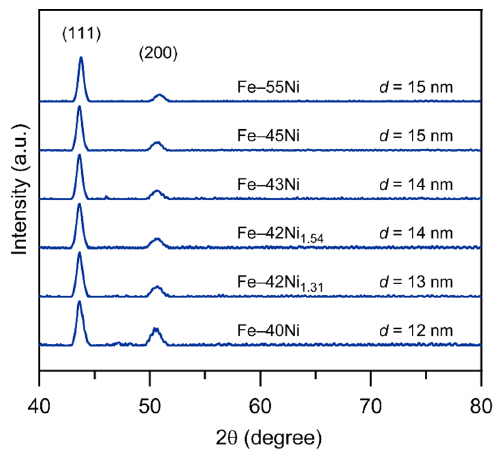
Figure 2. XRD patterns of electrodeposited bulk nanocrystalline Fe-Ni alloys. d stands for the grain size calculated from the XRD determination of the (111) peak width.